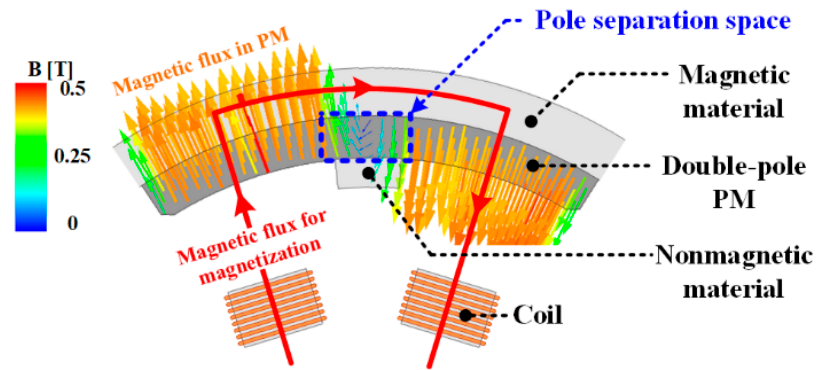
Figure 2. Schematics of the magnetizer structure for the double-pole PM.